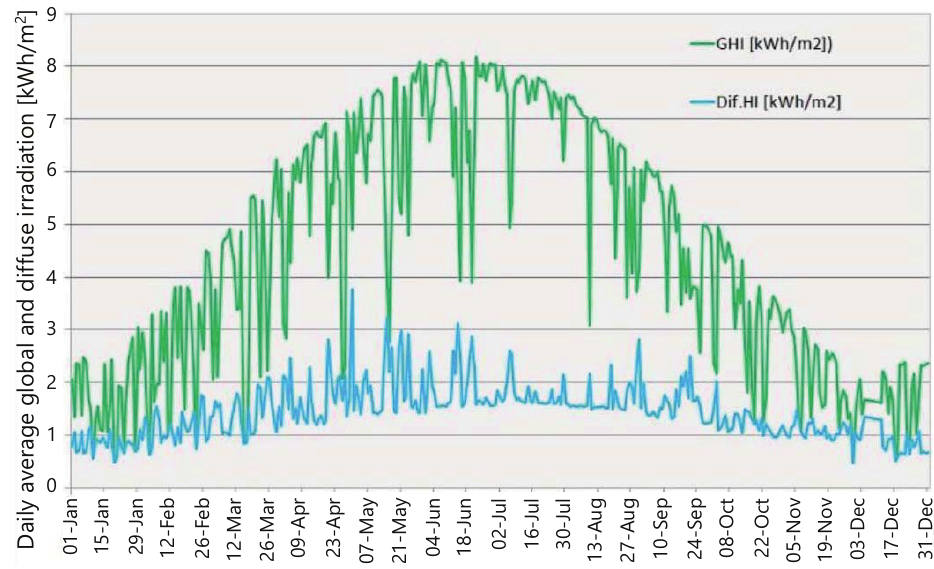
Figure 12. Average daily diffuse (blue) and global (green) irradiation of the typical year derived from measurements over the last 10 years.